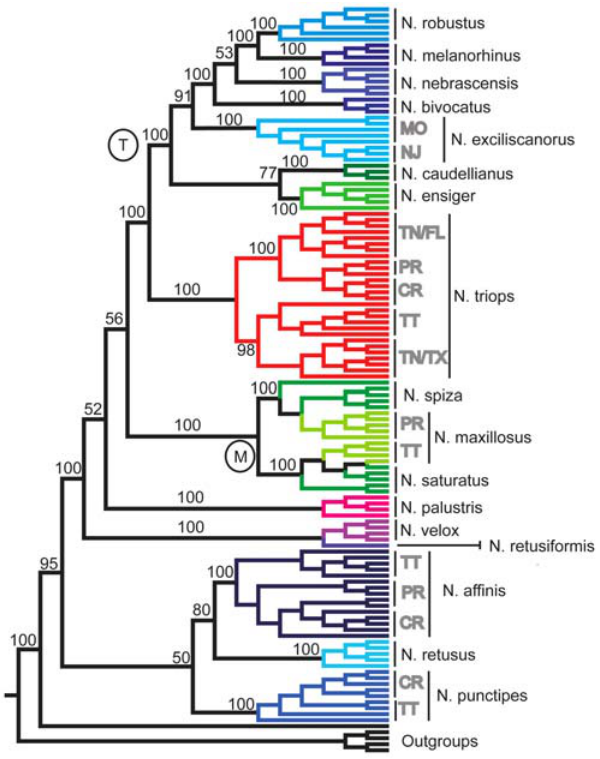
Figure 1. Phylogeny of Neoconocephalus based on AFLP analysis. Majority rule Bayesian AFLP phylogeny of 17 species of katydids. The species, as identified after [22,25] are indicated by color coding. Five species are represented by multiple geographic popula- tions; CR = Costa Rica, FL= Florida, USA, NJ= New Jersey, USA, MO=Missouri, USA, PR=Puerto Rico, TN=Tennessee, USA, TT=Trini- dad, and TX=Texas, USA. Nodal Support values, reported above nodes, are posterior probabilities in percent. Asterisks at the species names indicates temperate life history. The individuals included in this analysis are listed in the Table S1 in the sequence as they appear in this